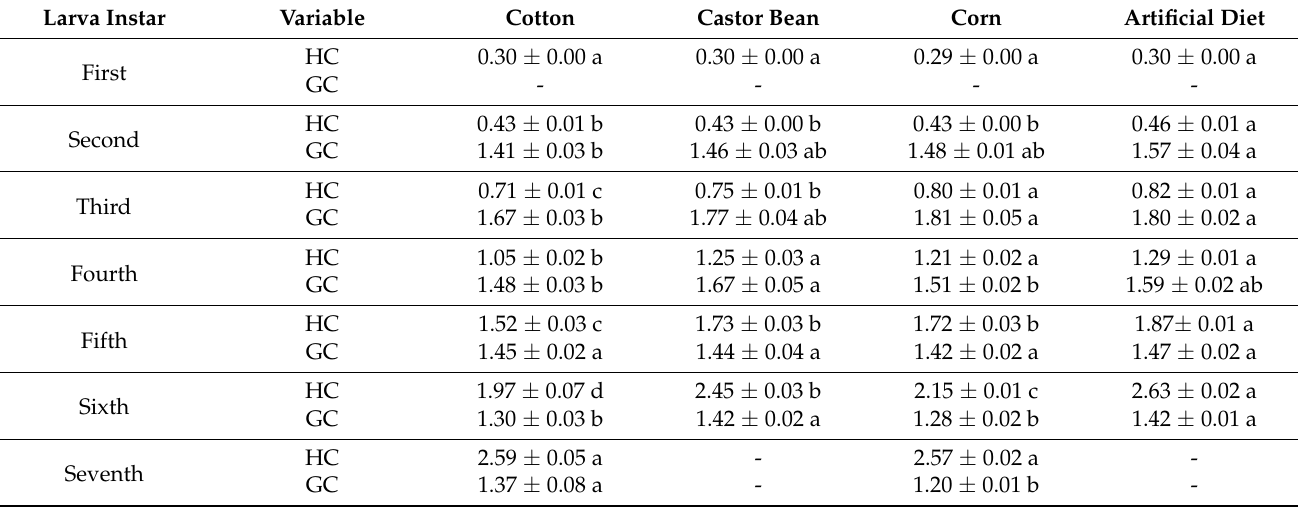
Table 3. Head capsule (HC) width and growth ratio (GR) of the first, second, third, fourth, fifth, sixth and seventh instars of Spodoptera frugiperda (Lepidoptera: Noctuidae) fed with pieces of cotton ( Gossypium hirsutum L.), castor bean ( Ricinus communis L.) and corn ( Zea mays L.) leaves and an artificial diet at 25 ± 2 ◦ C, relative humidity of 60 ± 10 and photophase of 12